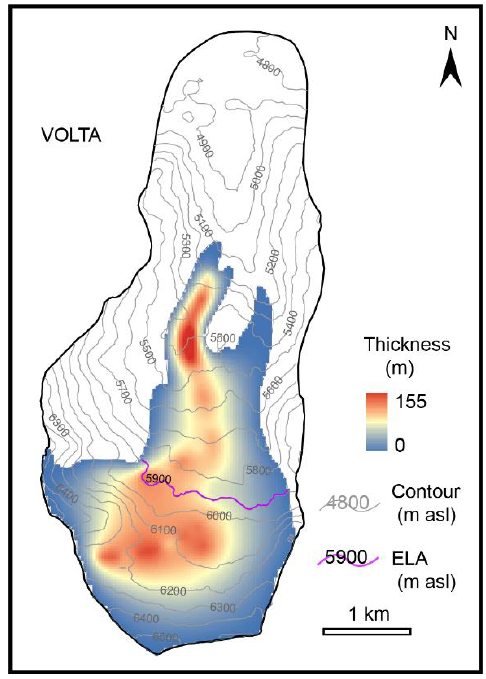
Figure 4. Modern glacier thickness derived from the VOLTA model and the reconstructed modern equilibrium line altitude (ELA) (accumulation area ratio (AAR) = 0.65, area-altitude balance ration (AABR) = 1.75). Table 1. Reconstructed glacial extent parameters for the Qiangyong Glacier at different Holocene stages. Area Glacial Stage (km 2 )